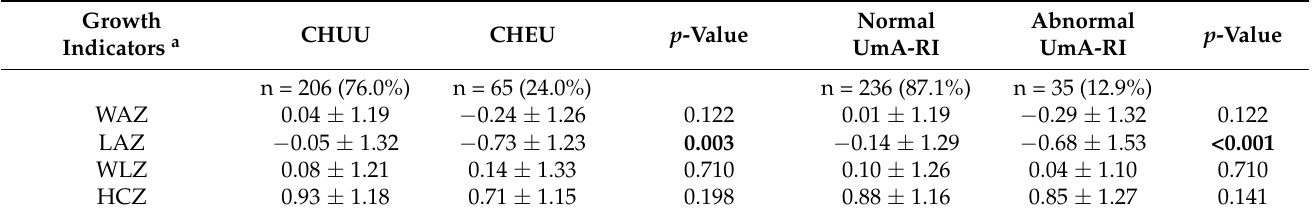
Table 3. The comparisons of mean growth outcomes at age 18 months in HIV-exposed vs. unexposed settings and normal vs. abnormal umbilical artery resistance index (UmA-RI) settings.